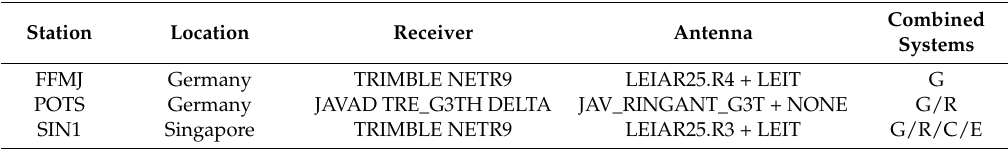
Figure 4. The convergence time for the 20-cm level for FFMJ ( left : bar series; right : cumulative distribution function (CDF) curve).